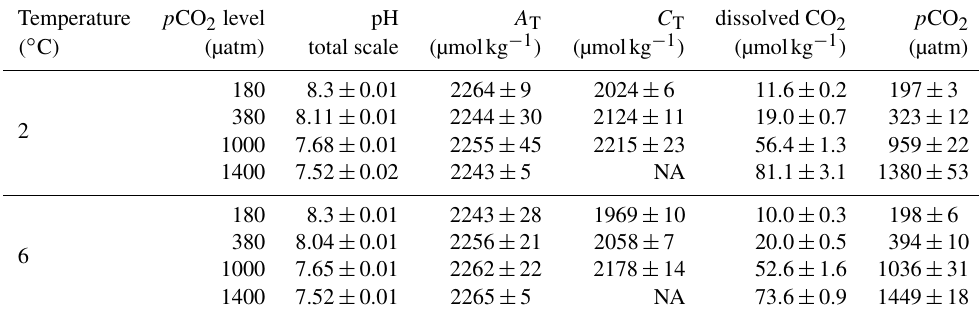
Table 1. Seawater carbonate chemistry at the end of the experiments ( n = 3; mean ± 1SD). CO 2 partial pressure ( p CO 2 ) and dissolved CO 2 concentrations were calculated from total alkalinity ( A T ) and pH total at 2 or 6 ◦ C, a salinity of 32.7 using CO 2 SYS (Pierrot et al., 2006), and phosphate and silicate concentrations of 10 and 100µmolkg − 1 , respectively. NA indicates that values are not available for this specific treatment.